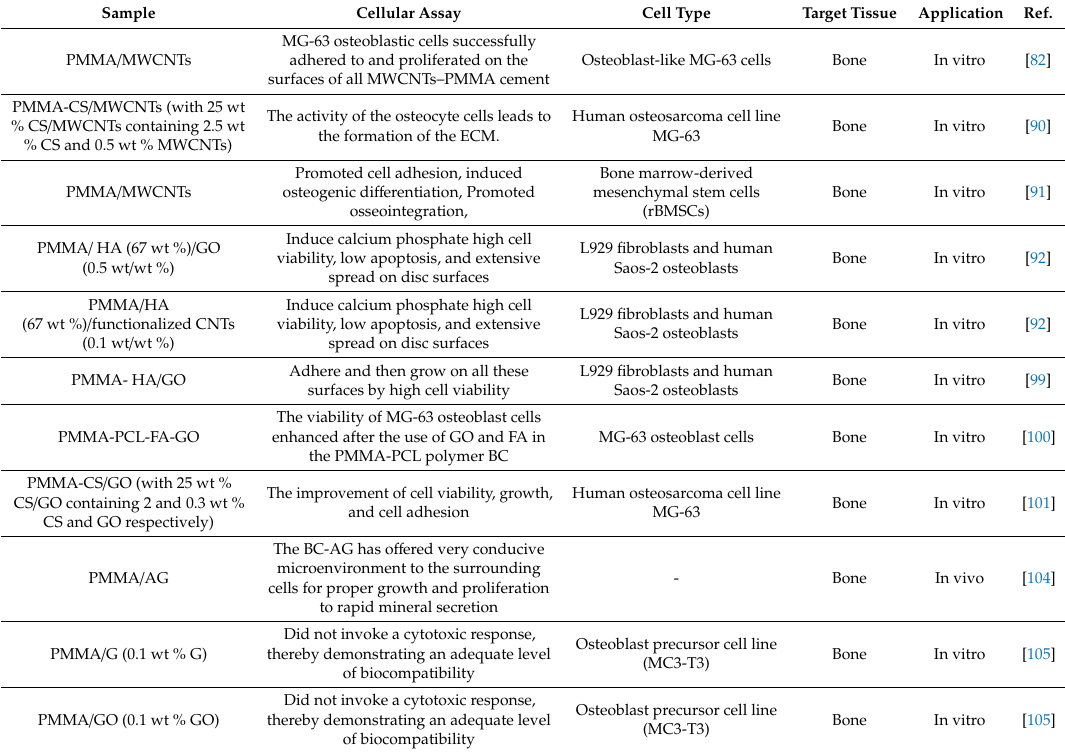
Table 3. Cellular responses of the PMMA-based BCs containing MWCNTs, CS / MWCNTs, HA / GO, HA / CNTs, PCL-FA-GO, CS / GO, AG, G and GO reinforcing agents. Sample Cellular Assay Cell Type Target Tissue Application Ref. MG-63 osteoblastic cells successfully adhered to and proliferated on the Osteoblast-like MG-63 cells Bone In vitro surfaces of all MWCNTs–PMMA cement PMMA-CS / MWCNTs (with 25 wt The activity of the osteocyte cells leads to % CS / MWCNTs containing 2.5 wt the formation of the % CS and 0.5 wt % MWCNTs)